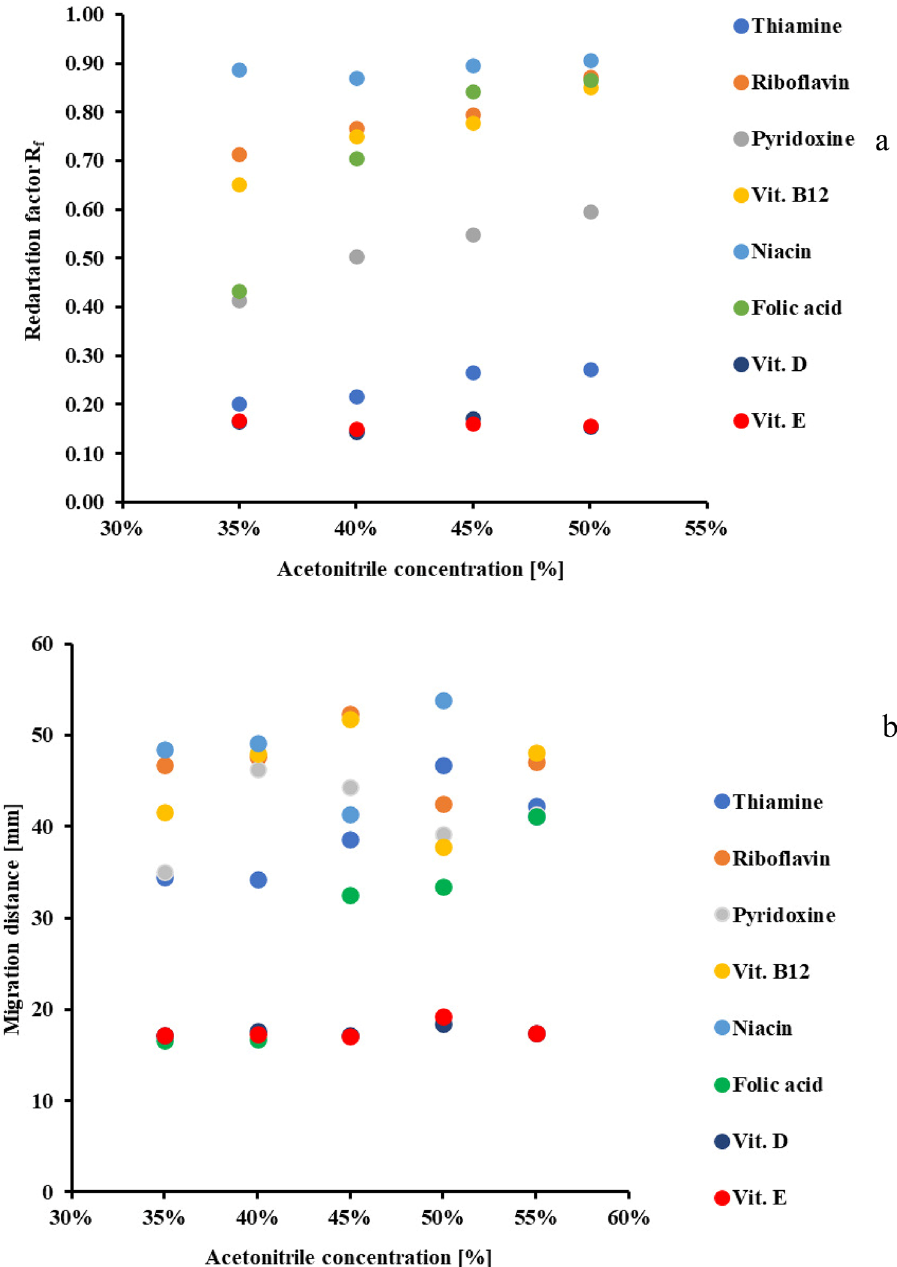
Figure 3. The effect of acetonitrile concentration on the investigated vitamin: ( a ) retention (in TLC) and ( b ) migration distance (in PPEC). The mobile phase composition consisted of aqueous buffer of pH 6.99 (acetic acid. phosphoric acid and boric acid (2.74 mM each) and sodium hydroxide (8.60 mM)), 18.75 mM of SDS and various acetonitrile content. For the PPEC technique, polarisation voltage was 800 V, experiment time was 8 min and the temperature was 23